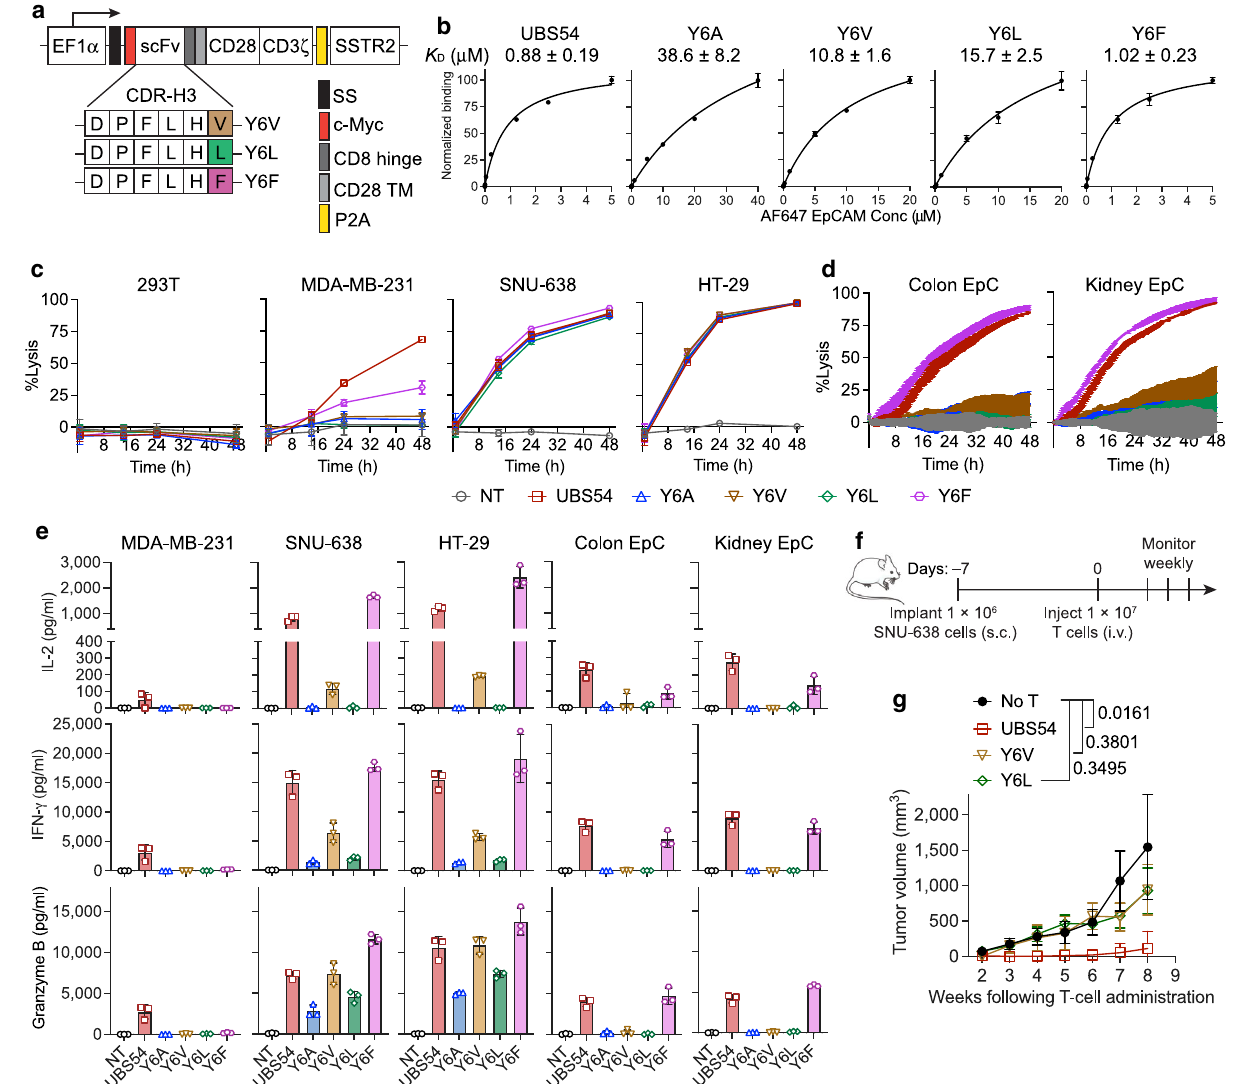
Fig. 2 | Activity of Y6X CAR-T cell variants. a Vector schematic of Y6X CAR variants: Y6V, Y6L, and Y6F. b The relative af fi nities of UBS54 and Y6X CARs determined by a saturation binding assay using AF647-conjugated monomeric EpCAM. Data represent mean±SD of triplicate samples. c Bioluminescence-based cytotoxicity assay using cell lines at an E:T ratio of 1:1. d Impedance-based cyto- toxicityassaymeasuringcytolyticactivityofCAR-Tcellsagainstprimarycolonand kidney epithelial cells (EpC) at an E:T ratio of 1:1. Data in c and d are presented as mean±SDoftriplicatewells( n =1T-celldonor). e Cytokinelevelsweremeasuredin